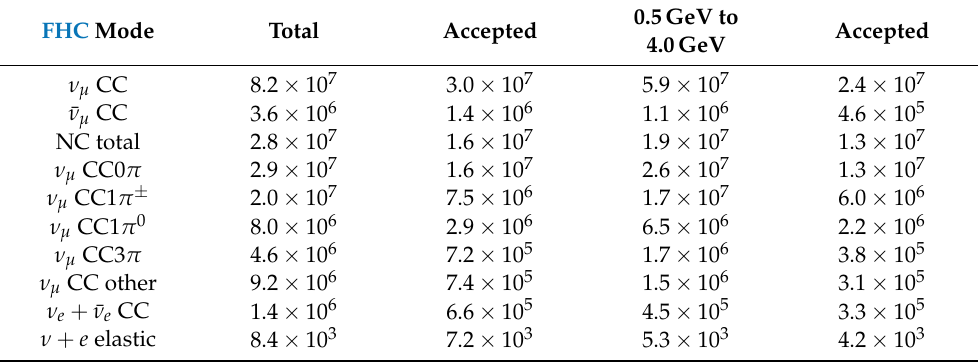
Table 10. FHC Event rates in ND-LAr (per year as defined in the text). Accepted is defined as the µ is either contained or matched to ND-GAr, and the hadronic shower is contained (<30MeV in the outermost 30cm of the